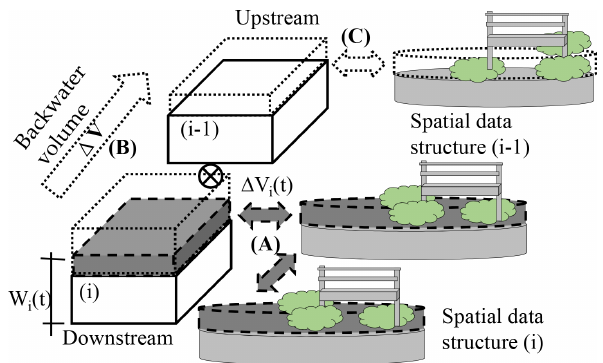
Figure 7. Scheme of the sub-calculation routines (A), (B) and (C) to compute backwater effects in stream segments and adjacent lowland areas (spatial data structures). The sub-calculation routines are part of the main calculation routine (b and c, Fig.